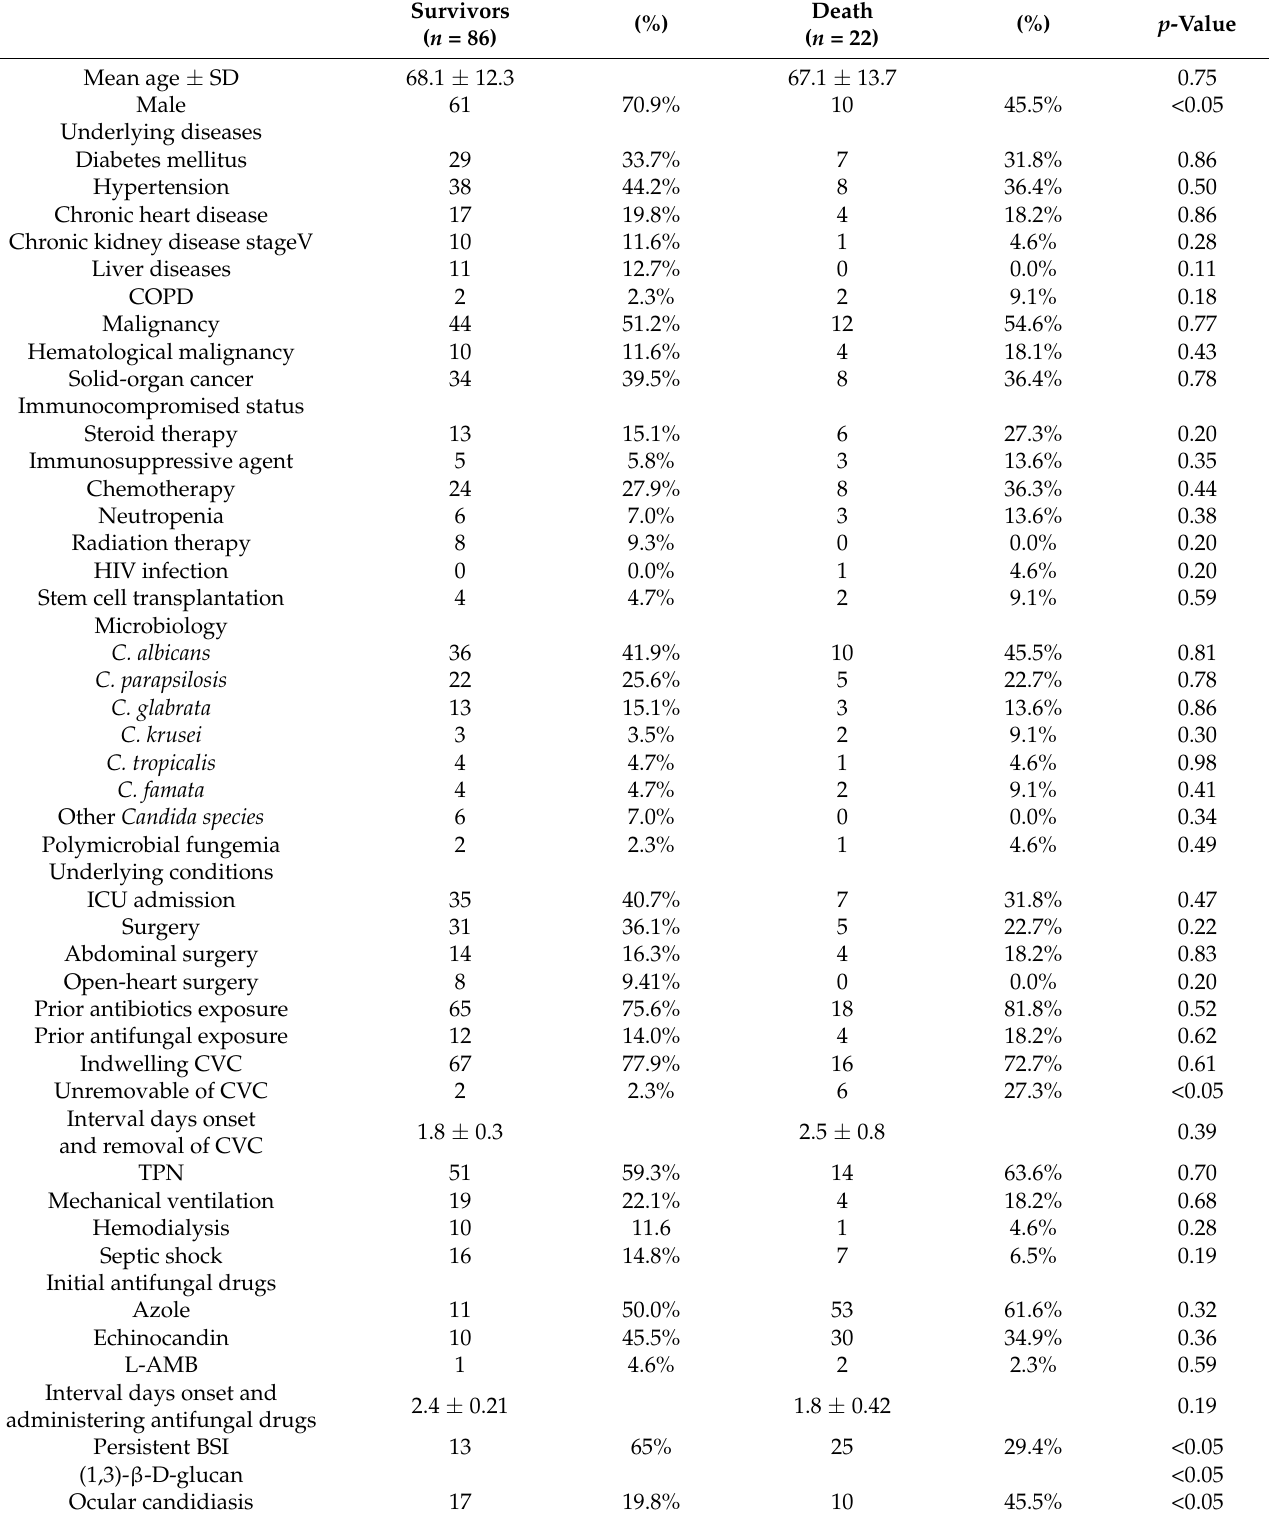
Table 4. Univariate analysis of factors associated with 30-day